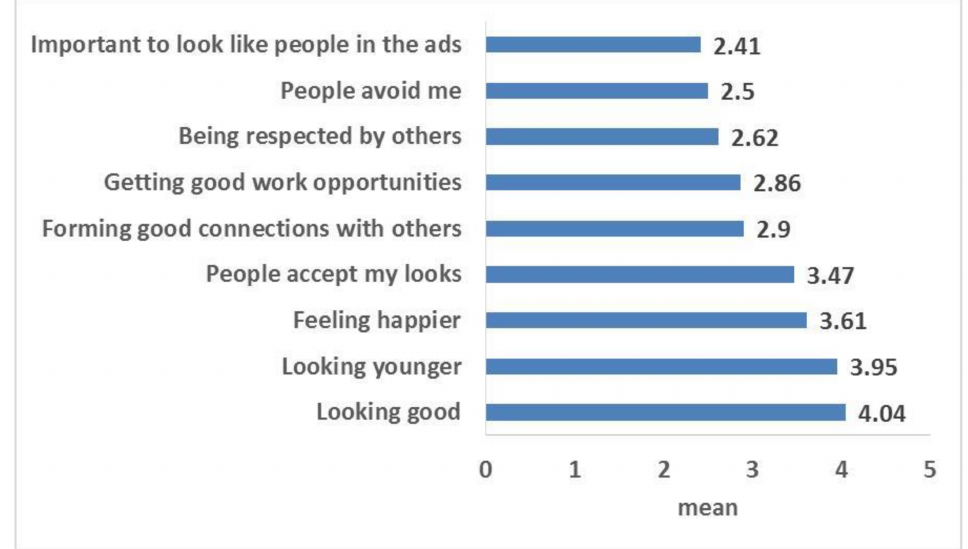
Figure 2. Attitude towards self-perceived tooth shade among the study participants (5 = completely agree). Table 3 represents the association between the dental esthetic attitude with the self- perceived tooth shade and different background factors. In the univariate regression (unadjusted model), an older age was significantly associated with a better attitude score (B = 0.008, p = 0.04), while the perceived b* was associated with lower attitude scores (B = − 0.04, p = 0.03). Also, the males (versus the females) who had not received any dental education and preclinical students (versus clinical students), had significantly better attitude scores. In the adjusted model, the males showed better attitude scores than the females (B = 0.18, p = 0.009). Those who had not received any dental education also showed better attitude scores than the clinical dental students (B = 0.37, p = 0.008). The adjusted R 2 of the model =